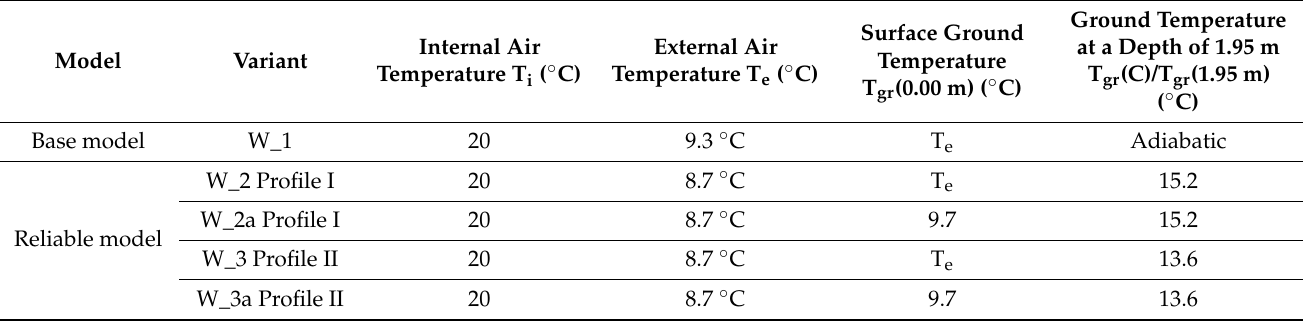
Table 3. Temperatures adopted in the